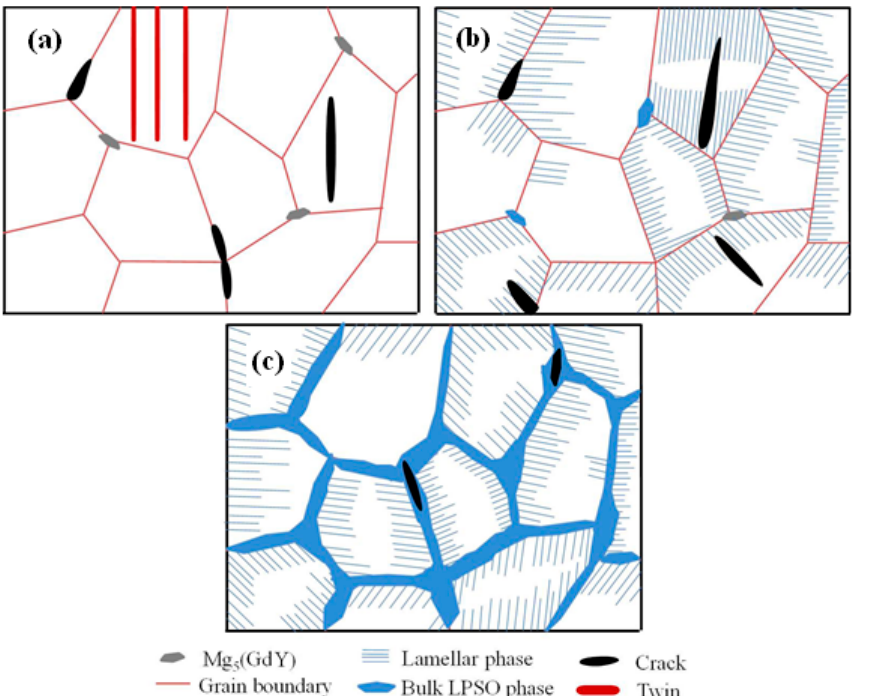
Figure 9. Schematic diagram of fracture of the as-cast alloys: ( a ) 0Zn, ( b ) 0.7Zn/1.5Zn, and ( c ) 3.3Zn alloys. ( c ) 3.3Zn